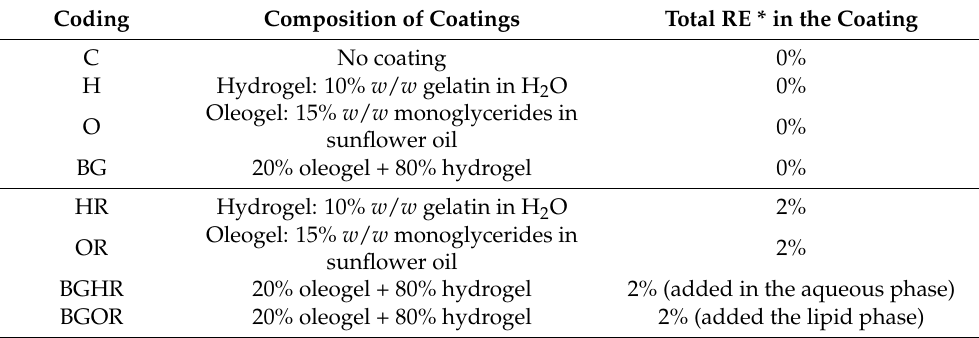
Table 2. Composition and coding of the different gel coatings of the refrigerated sardine fillets. Coding Composition of Coatings Total RE * in the Coating C No coating 0% H Hydrogel: 10% w / w gelatin in H 2 O 0% Oleogel: 15% w / w monoglycerides in 0% O sunflower oil BG 20% oleogel + 80% hydrogel 0% HR Hydrogel: 10% w / w gelatin in H 2 O 2% Oleogel: 15% w / w monoglycerides in 2% OR sunflower oil BGHR 20% oleogel + 80% hydrogel 2% (added in the aqueous phase) BGOR 20% oleogel + 80% hydrogel 2% (added the lipid